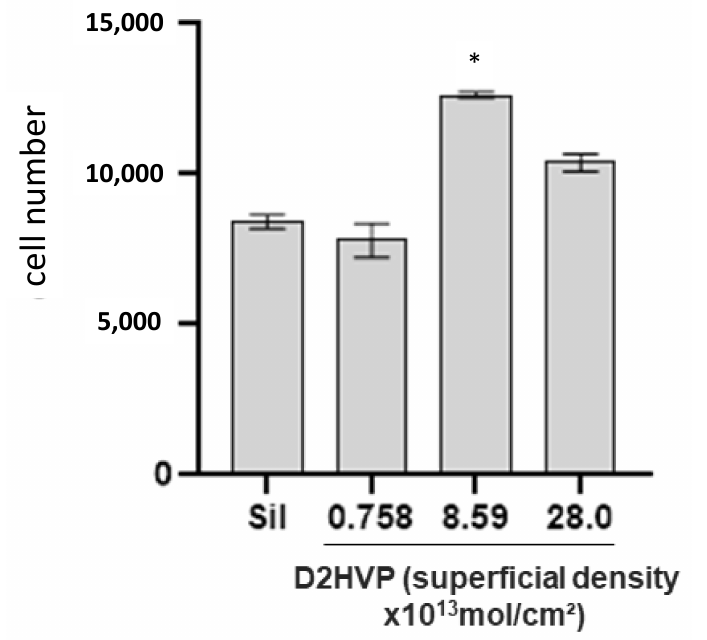
Figure 1. Evaluation of the superficial peptide density for h-osteoblast adhesion maximization. Adhesion assay of human osteoblasts following 2 h incubation on Ti disks grafted with D2HVP at different superficial densities. “Sil” represents the silanized titanium disks. * Denotes p < 0.05 vs. Sil.